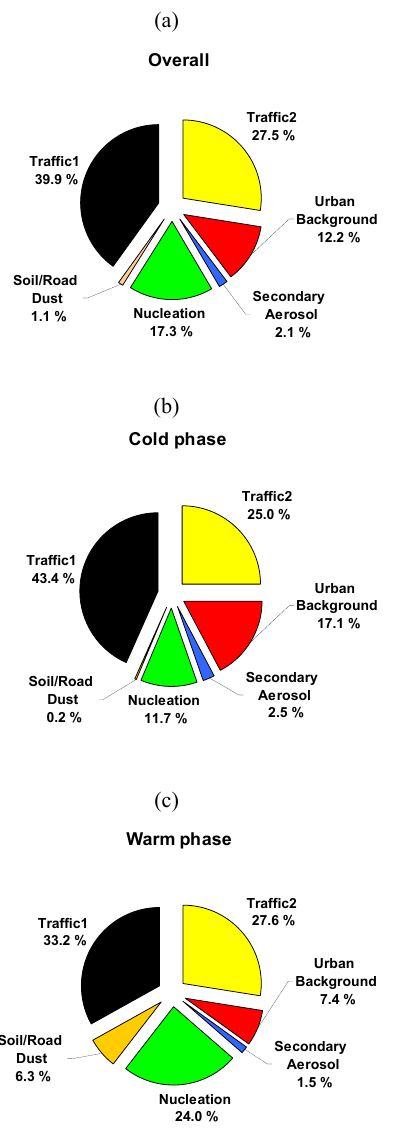
Figure 5. Relative contribution of each factor to the total number concentrations: (a) overall phases; (b) cold phase; and (c) warm phase.